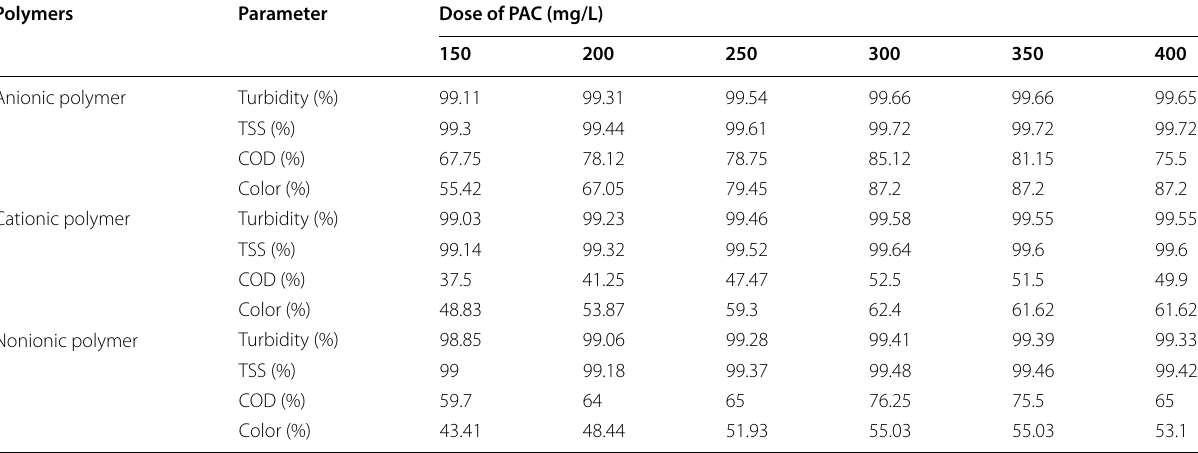
Table 2 The effects of anionic, cationic and nonionic polymer (0.5 mg/L) at different doses of PAC on the tile wastewater (at optimum pH 7) =